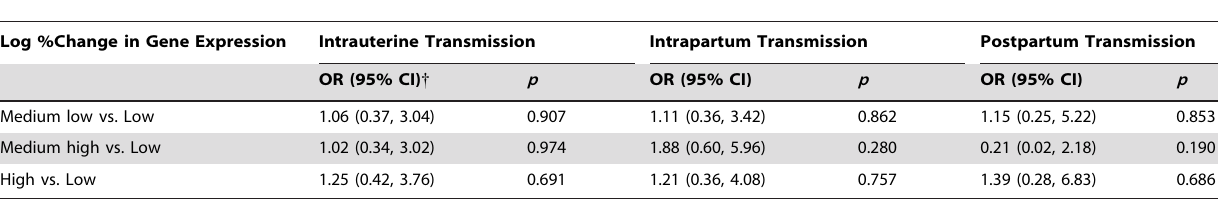
Table 3. Association between CCR5 placental expression and the risk of HIV MTCT at different time points.